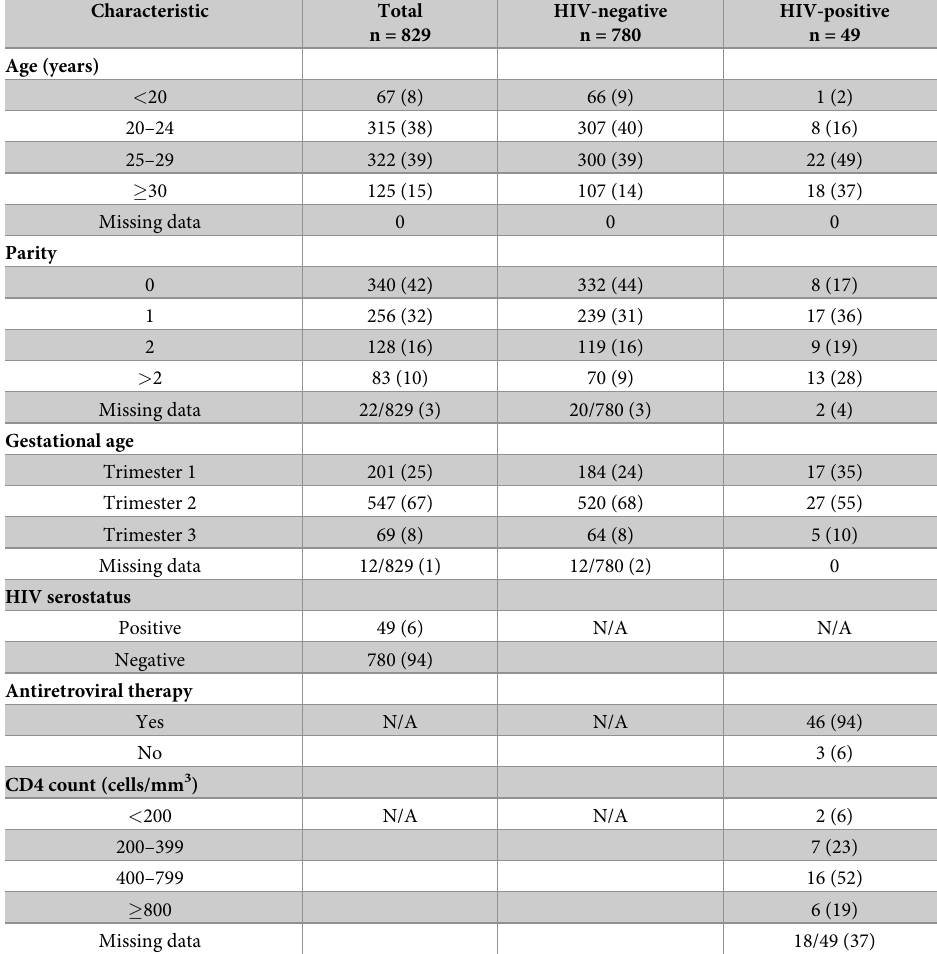
Table 1. Study participant characteristics categorized by HIV serostatus. Characteristic